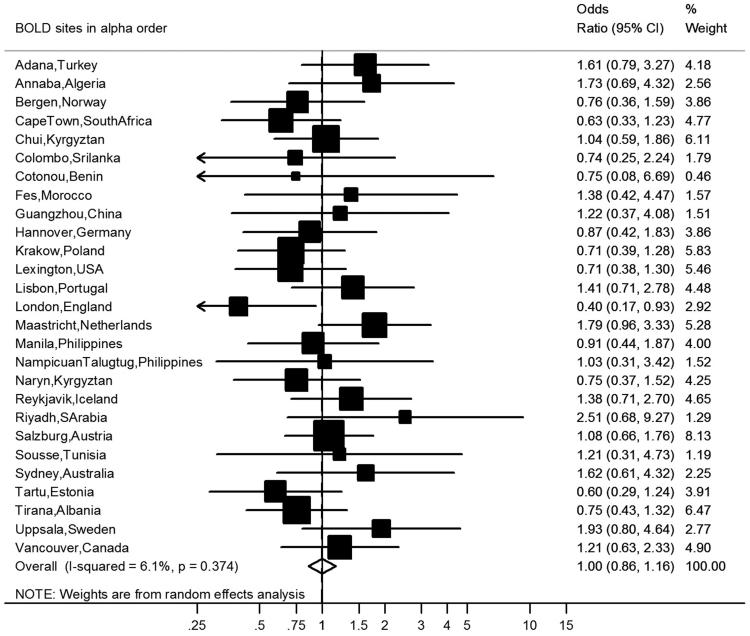
Meta-analysis of the adjusted odds ratios for CVD in subjects with airflow obstruction. Forest plot showing the meta-analysis of odds ratios for CVD, adjusting for age, smoking (pack-years and current smoking status), BMI, education and sex in subjects with airflow obstruction compared to those without airflow obstruction. Heterogeneity chi-squared = 27.68, d.f. = 26 (P = 0.374). I-squared (variation in ES attributable to heterogeneity) = 6.1%. Estimate of between-study variance Tau-squared = 0.0095. Test for overall effect: Z = 0.00 (P = 0.999). The following sites could not be included in the analysis due to a low number of subjects reporting CVD or singularity in the data: Blantyre (Malawi), Ife (Nigeria), Mumbai (India), Penang (Malaysia), Pune (India), Srinagar (India).